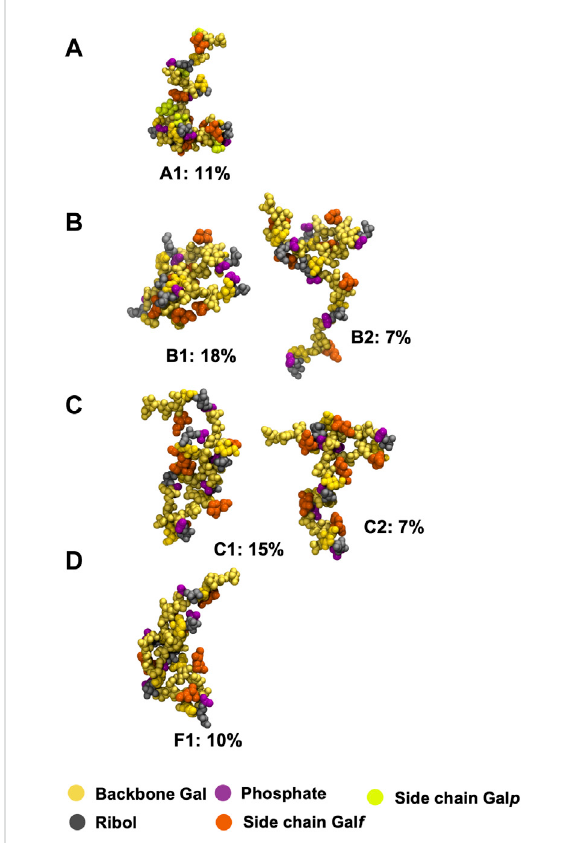
FIGURE 4 Main conformational families identi fi ed for the 6 RU S. pneumoniae serotype CPS, with the terminal repeat units (RU 1 and RU 6) excluded from analysis: (A) Pn10A, (B) Pn10B, (C) Pn10C, and (D) Pn10F. Backbone galactose residues are shown in yellow, ribitol residues shown in grey, phosphate in purple, side group galactofuranose residues in orange, and side group galactopyranose residues in light green. The primary clusters occurred regularly throughout the trajectory. The secondary cluster of Pn10B occurred regularly in the second half of the simulation along with the primary cluster; for Pn10C the secondary cluster occurred only for ~400 ns around the 1,500 ns